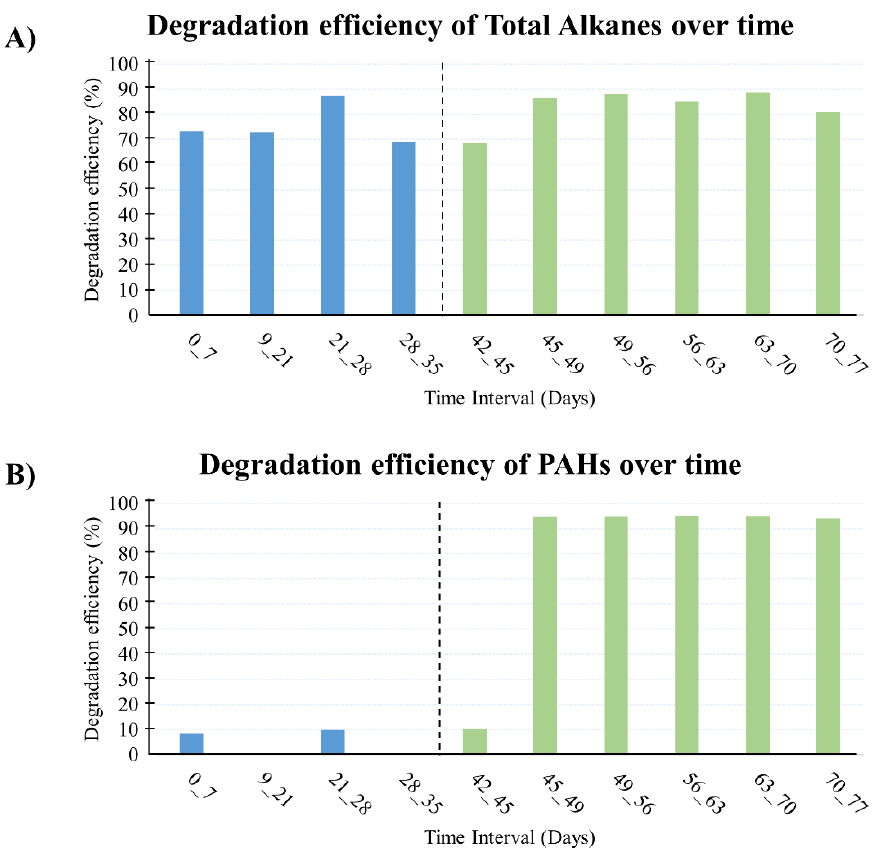
Figure 7. Total alkanes ( A ) and PAHs ( B ) degradation for every time interval. Blue bars represent the first part of the time-series experiment, where only oil was added (OIL treatment). Green bars represent the second part, where oil and dispersant were added (OIL + D treatment).